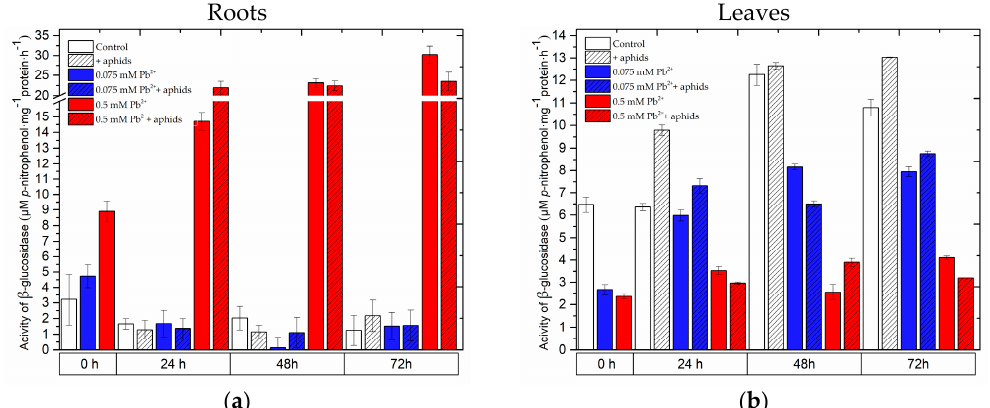
Figure 7. The effect of lead and A. pisum on β -glucosidase activity in roots ( a ) and leaves ( b ) of pea seedlings. The data were obtained in three independent experiments and statistically analysed using ANOVA ( p -values at α = 0.05). Hypotheses on the equality of means were verified by the two-sample t -test. To account for multiple testing, we used the Bonferroni correction (statistically significant differences are shown in Table S1).